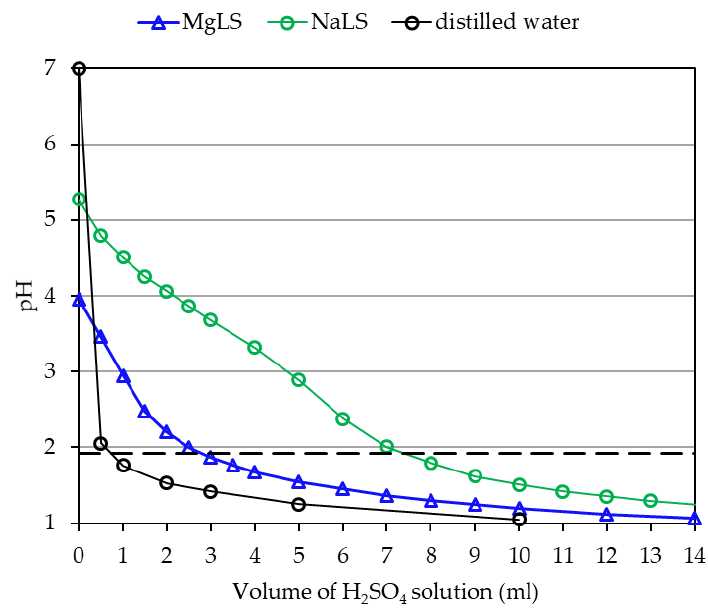
Figure 5. Curves of variation of pH as a function of titration with 0.309 M H 2 SO 4 of lignosulfonate solutions or distilled water. Mass of the solution is 40 g. Concentration of lignosulfonate is 6%. The dotted line shows the pH of the cured resin with (NH 4 ) 2 SO 4 without lignosulfonates.